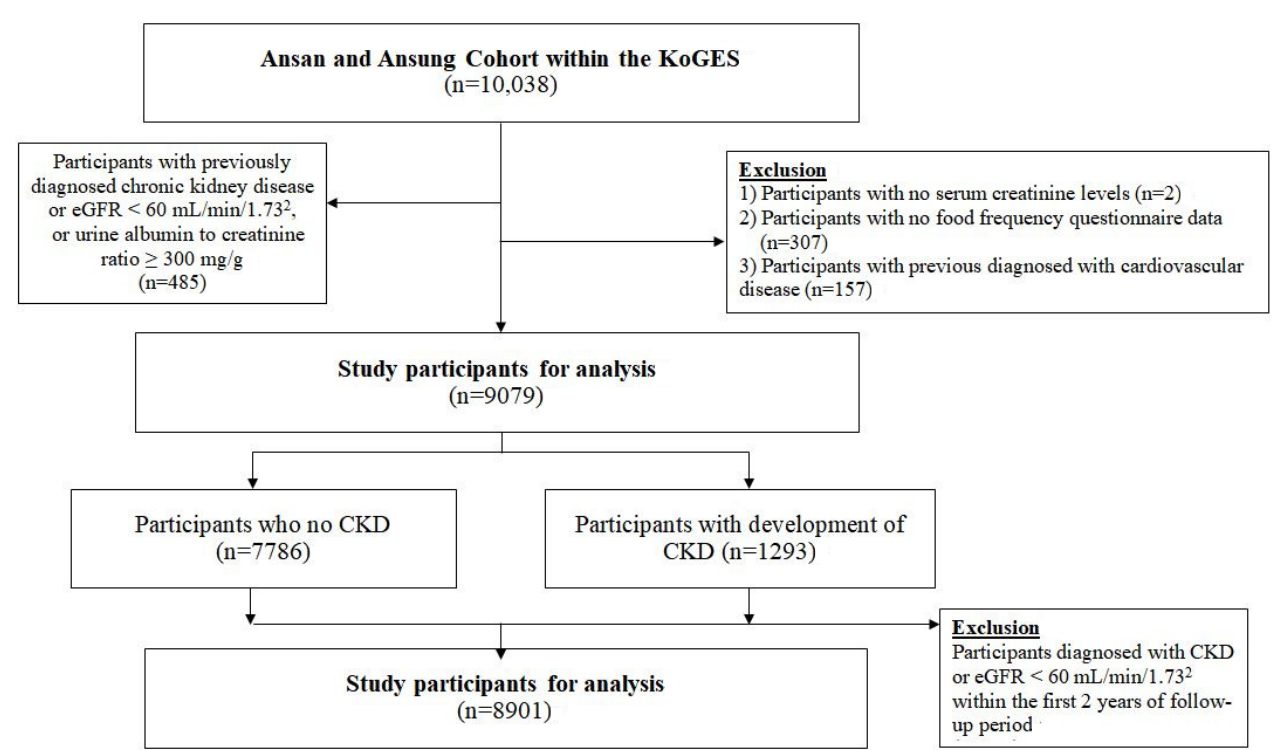
Figure 1. Study subjects to assess the association between dietary minerals and vitamins with development of chronic kidney disease, the Ansan-Ansung cohort of the Korean Genome and Epidemiologic study (KoGES). KoGES, Korean Genome and Epidemiologic Study; eGFR, estimated glomerular filtration rate; CKD, chronic kidney disease.